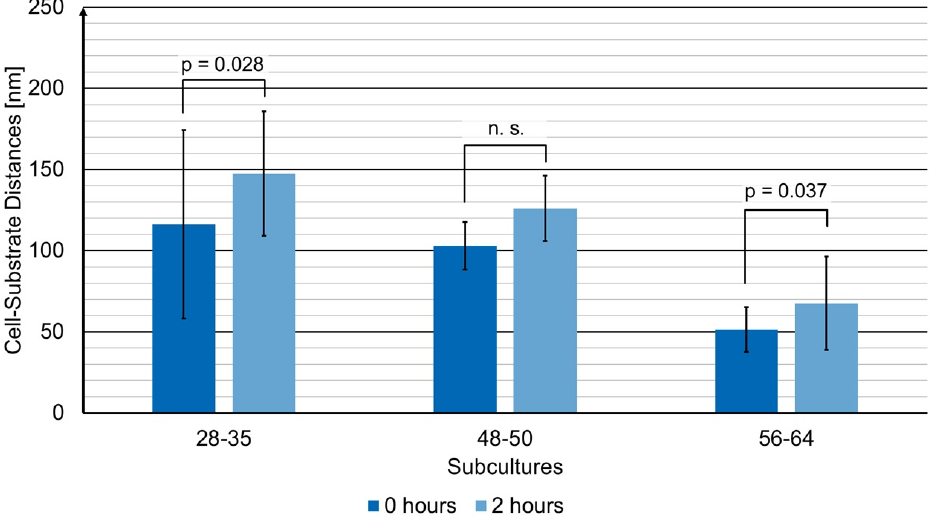
Figure 4. Most frequent cell ‐ substrate distances evaluated from all histograms of the subcultures with 28–35, 48–50, and 56–64 cell splittings as mean value ± standard deviation including the p -values for statistical significance ( p ≤ 0.05: statistically significant; n.s.: nonsignificant). Results are shown for 0 h and 2 h incubation with doxorubicin (2 μ M).